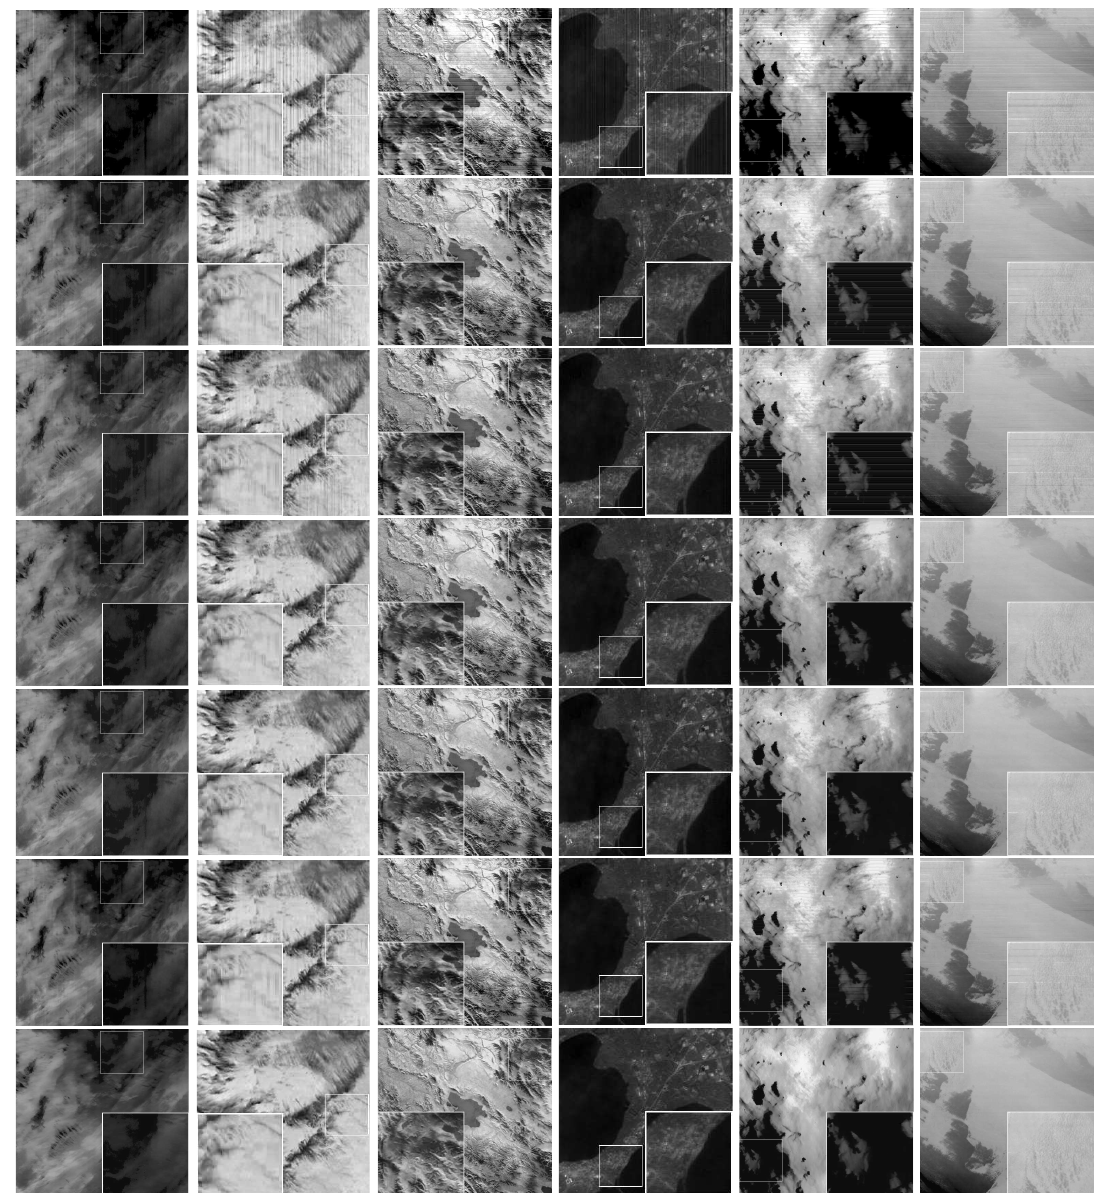
Figure 7. The visual results of different real images. From top to bottom: the real images, the destriping results of WFAF, SLD, UTV, GSLV, LRSID, and Ours. Readers are recommended to zoom in all figures for better